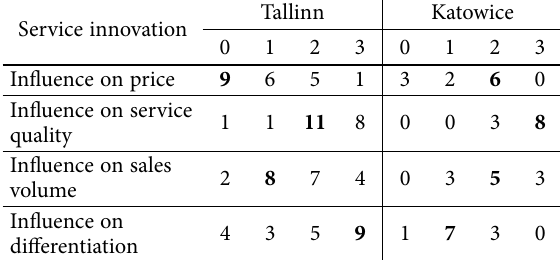
Table 3. Service innovation influences in the air cargo of Tallinn and Katowice regions Service innovation